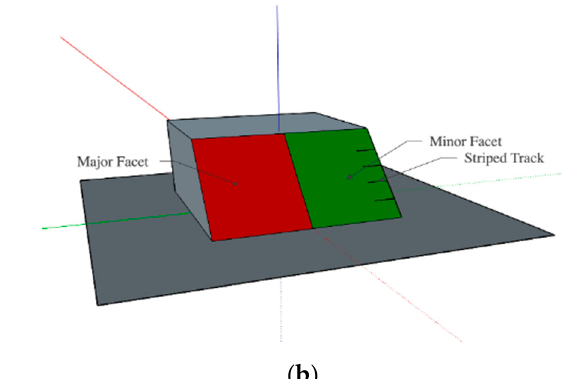
Figure 8. Example of the vertical slope type. These facets are the same facets shown in Figure 7a ( σ max = 800 MPa, R = − 0.5, N f = 4.7 × 10 6 ). ( a ) 3D-SEM image; ( b ) 3D-model schematic image.